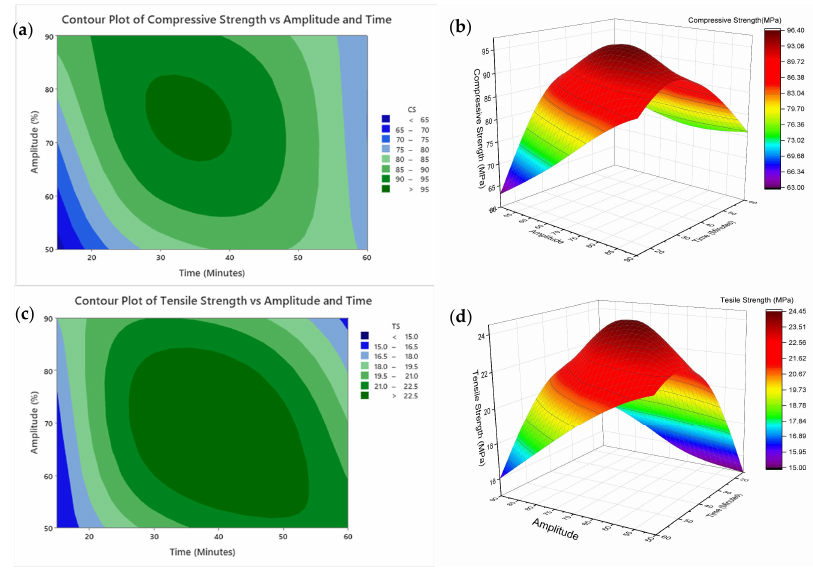
Figure 8. ( a ) Contour plot and ( b ) 3D poly curve of compressive strength shows the range and peak values with varying amplitudes and times. Similarly, ( c ) contour plot and ( d ) 3D poly curve shows the range of tensile strength and peak values with varying amplitudes and times.